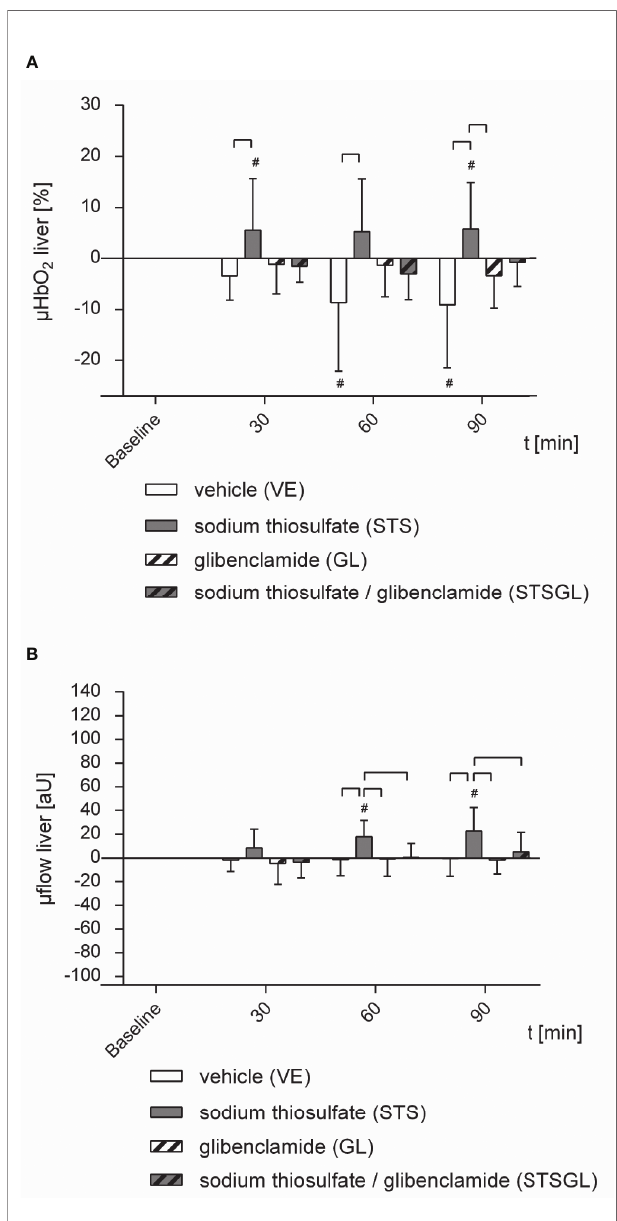
FIGURE 3 | Hepatic microcirculation in septic animals. Effect of sodium thiosulfate (STS), glibenclamide (GL), sodium thiosulfate + glibenclamide (STSGL) or vehicle (VE) on (A) hepatic microcirculatory oxygenation (µHBO 2 ) and (B) hepatic microcirculatory fl ow (µ fl ow). D µHBO 2 [%] and D µ fl ow [aU] over time calculated to baseline (means ± SD). # = p < 0.05 versus baseline (Two-way ANOVA followed by Dunnett´s post - hoc test) ⎴ between groups (Two-way ANOVA followed by Tukey post – hoc test); n = 10.